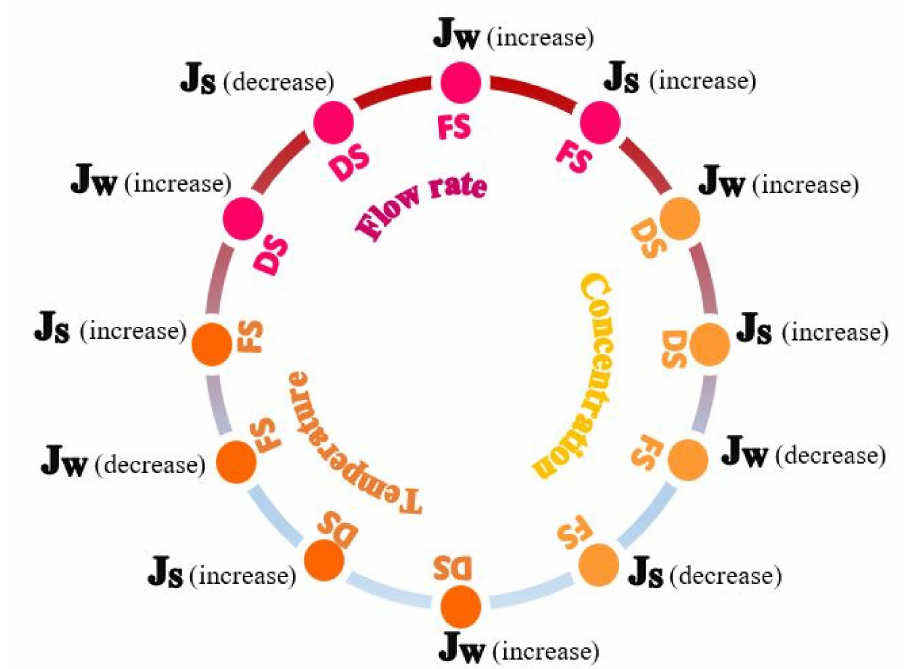
Figure 11. Effect increasing of operating conditions for feed solution (FS) or draw solution (DS) on FO